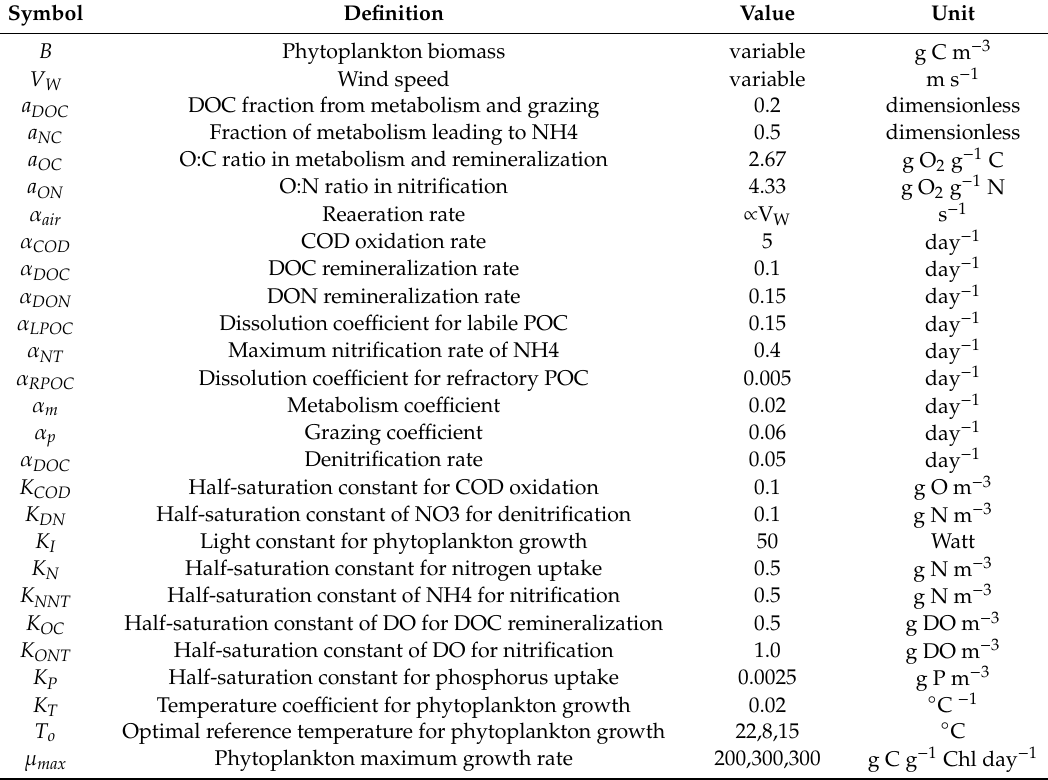
Table 1. Parameter definition, values and units of the model